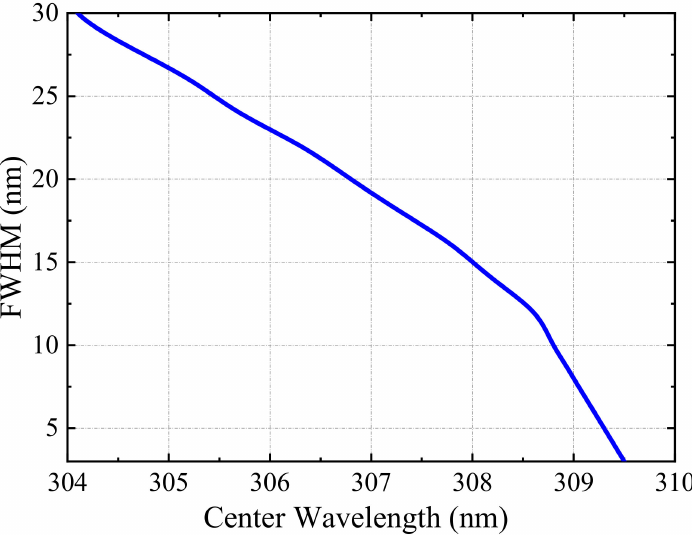
Figure 4. The optimal matching between the central wavelength and bandwidth of the filter. In an effort to understand the optimal matching further, the variation in the detection limit of the SO 2 camera system with the central wavelength and the bandwidth is also simulated (see Figure 5). Here, the color bar is inverted, indicating that the darker the color, the lower the detection limit and the better the system performance. The choice of bandwidth greatly impacts the system sensitivity. The model indicates that the minimum detection limit of the SO 2 camera system is centered at 309 nm, with an FWHM of 10 nm for the signal channel. The solar scattered light non-vertical incidence will cause the filter transmission curve to shift toward short wavelengths. In such cases, a large λ C can be selected to calibrate the error.